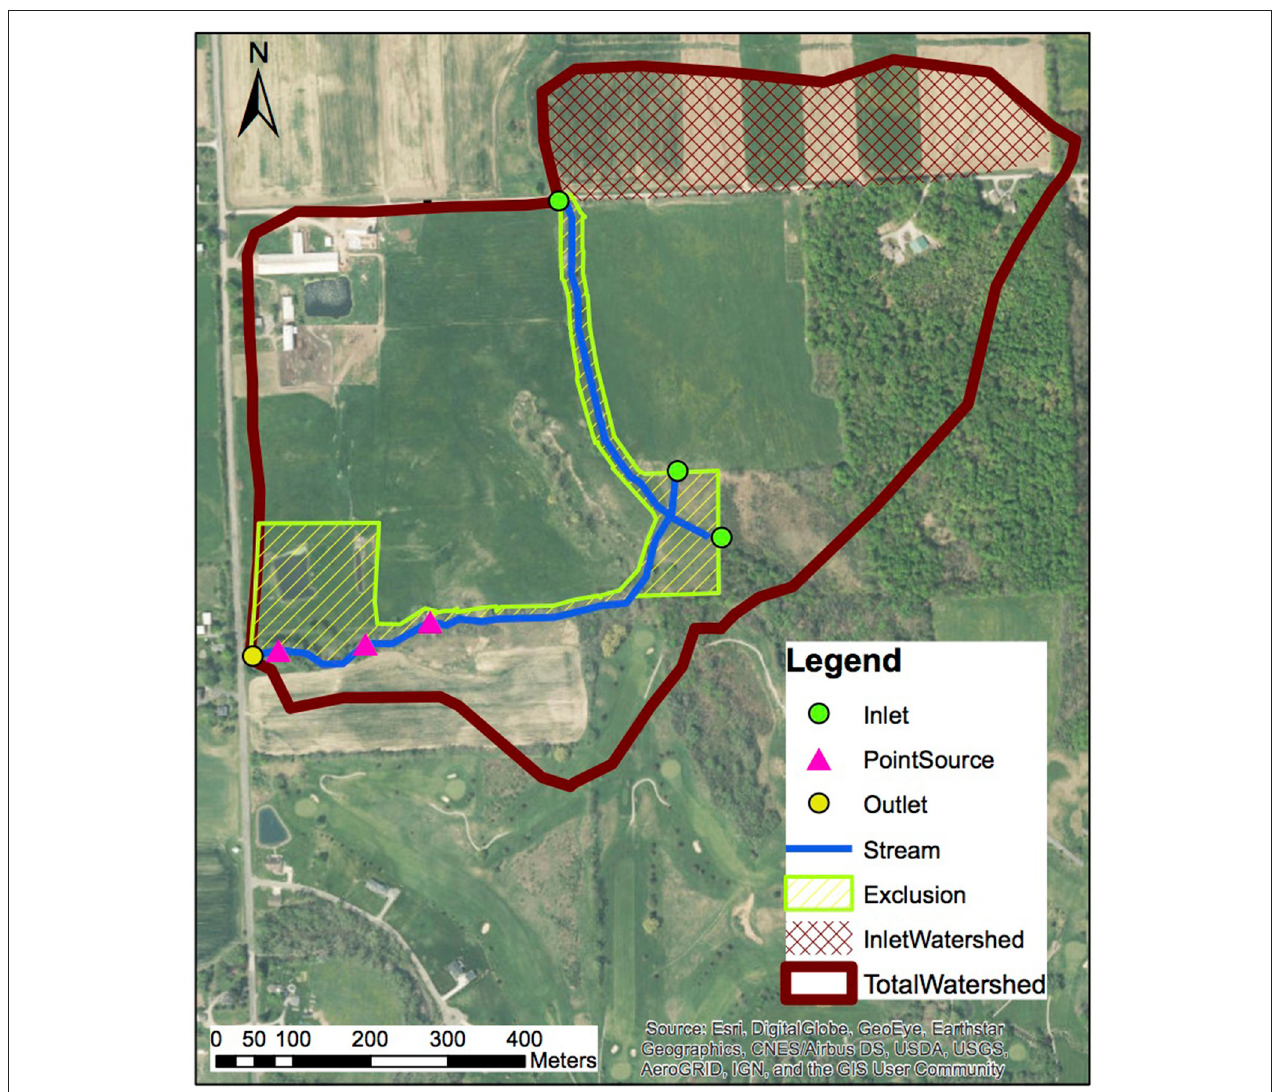
FIGURE 1 | Study watershed. Inlet watershed comprises of fields draining into a road ditch that feeds the inlet of the stream. Northern watershed boundary has been significantly altered from natural flow regime by agricultural infrastructure development. In the subsequent discussion point sources of pond effluent, tile drainage, and cow generated saturated areas correspond with point sources from west to east respectively in the figure above. This image was taken pre-BMP implementation. The three renovated settling ponds are located in the boxed exclusion area near the stream outlet and collect manure overflow from the manure pit shown in the north-western corner of the watershed. Of the three inlets, only the northern-most inlet point is used as the inlet in this study. This map was created using ArcGIS software by Esri. ArcGIS and ArcMap are the intellectual property of Esri and are used here under license (ESRI,